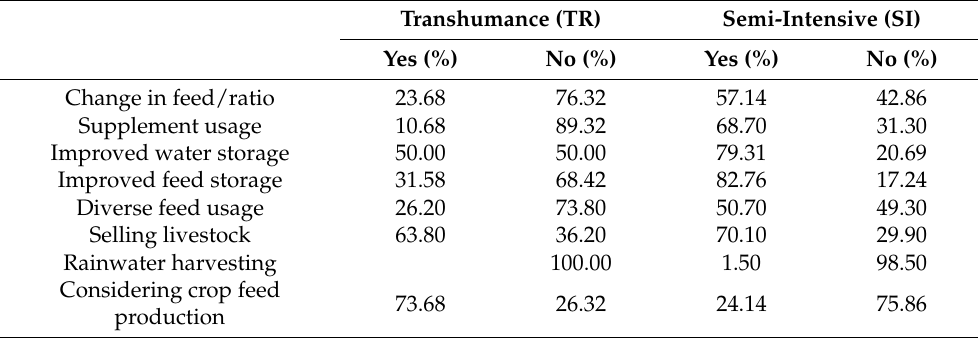
Table 3. Farmers’ adaptation and coping